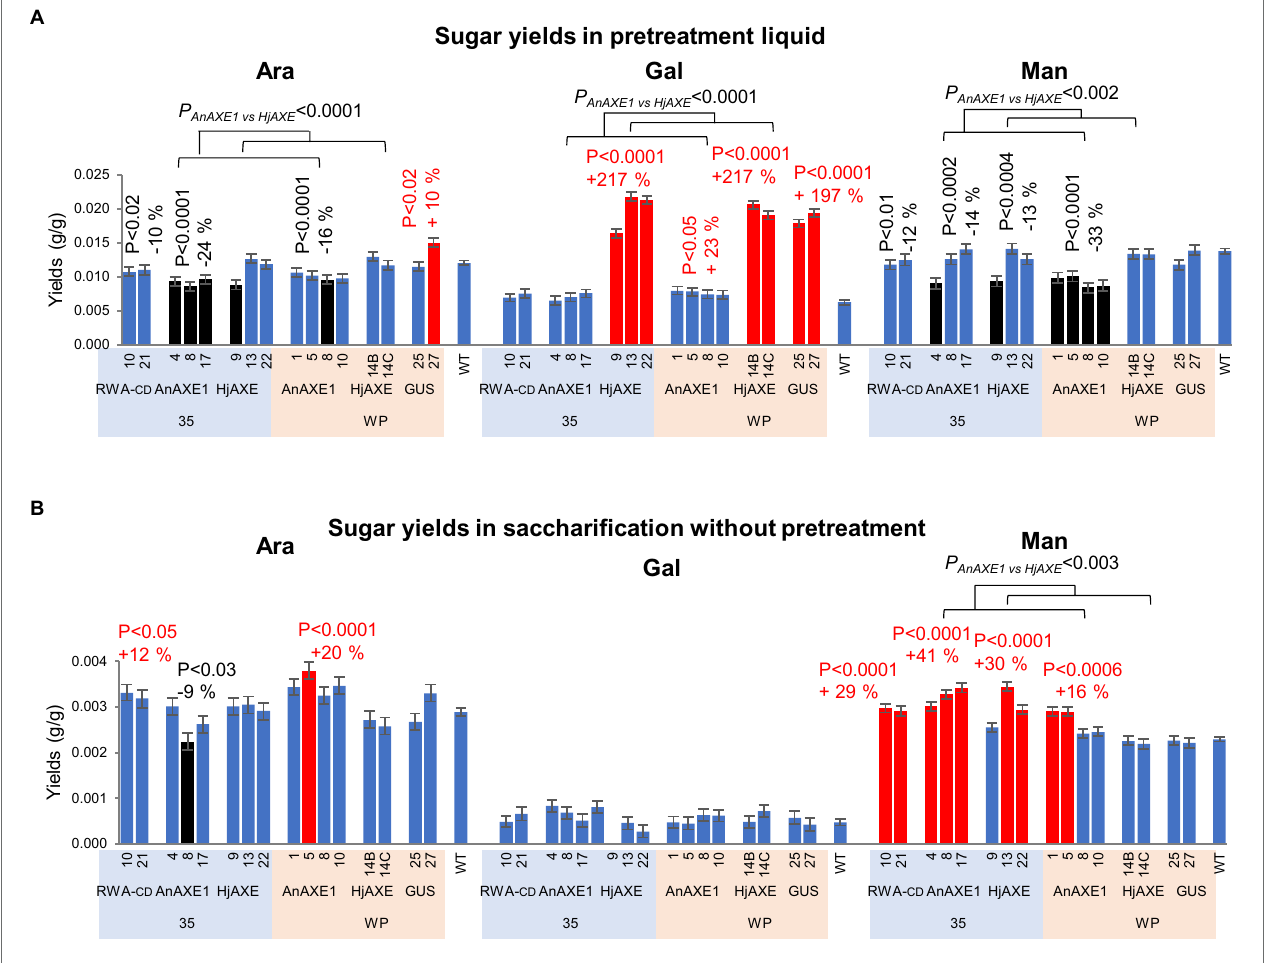
FIGURE 6 | Saccharification parameters of transgenic five-year-old field-grown aspen (minor sugar yields). (A) Arabinose, galactose, and mannose yields in saccharification with acid pretreatment. The sugars were only detected in the pretreatment liquid. (B) Arabinose, galactose, and mannose yields in saccharification without pretreatment. Means ± SE . Significant differences according to ANOVA followed by Dunnett’s test ( p < 5%) are indicated by color (red – higher and black – lower, than WT parameters). The values of p show the significance of differences between all the lines carrying indicated constructs and WT plants (post-ANOVA contrast, shown when < 5%). Effects of the transgene ( AnAXE1 vs. HjAXE ) were assessed by ANOVA F-